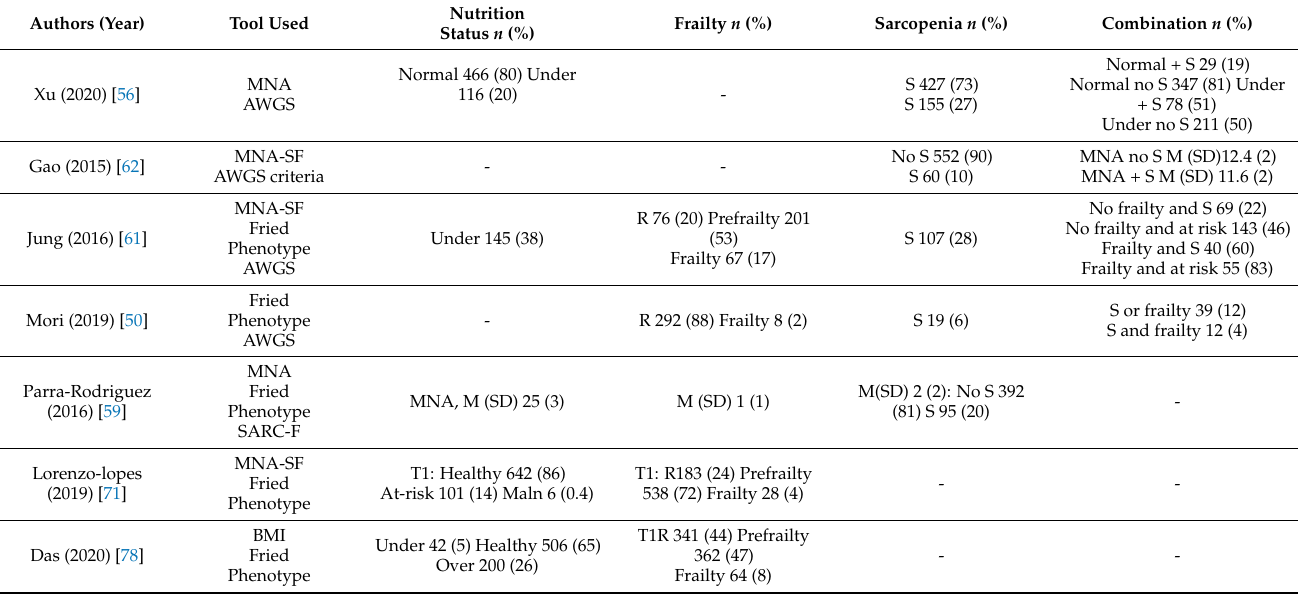
Table 3. Prevalence and incidence in studies of people with the combination of two or more undernu- trition, frailty, or sarcopenia.